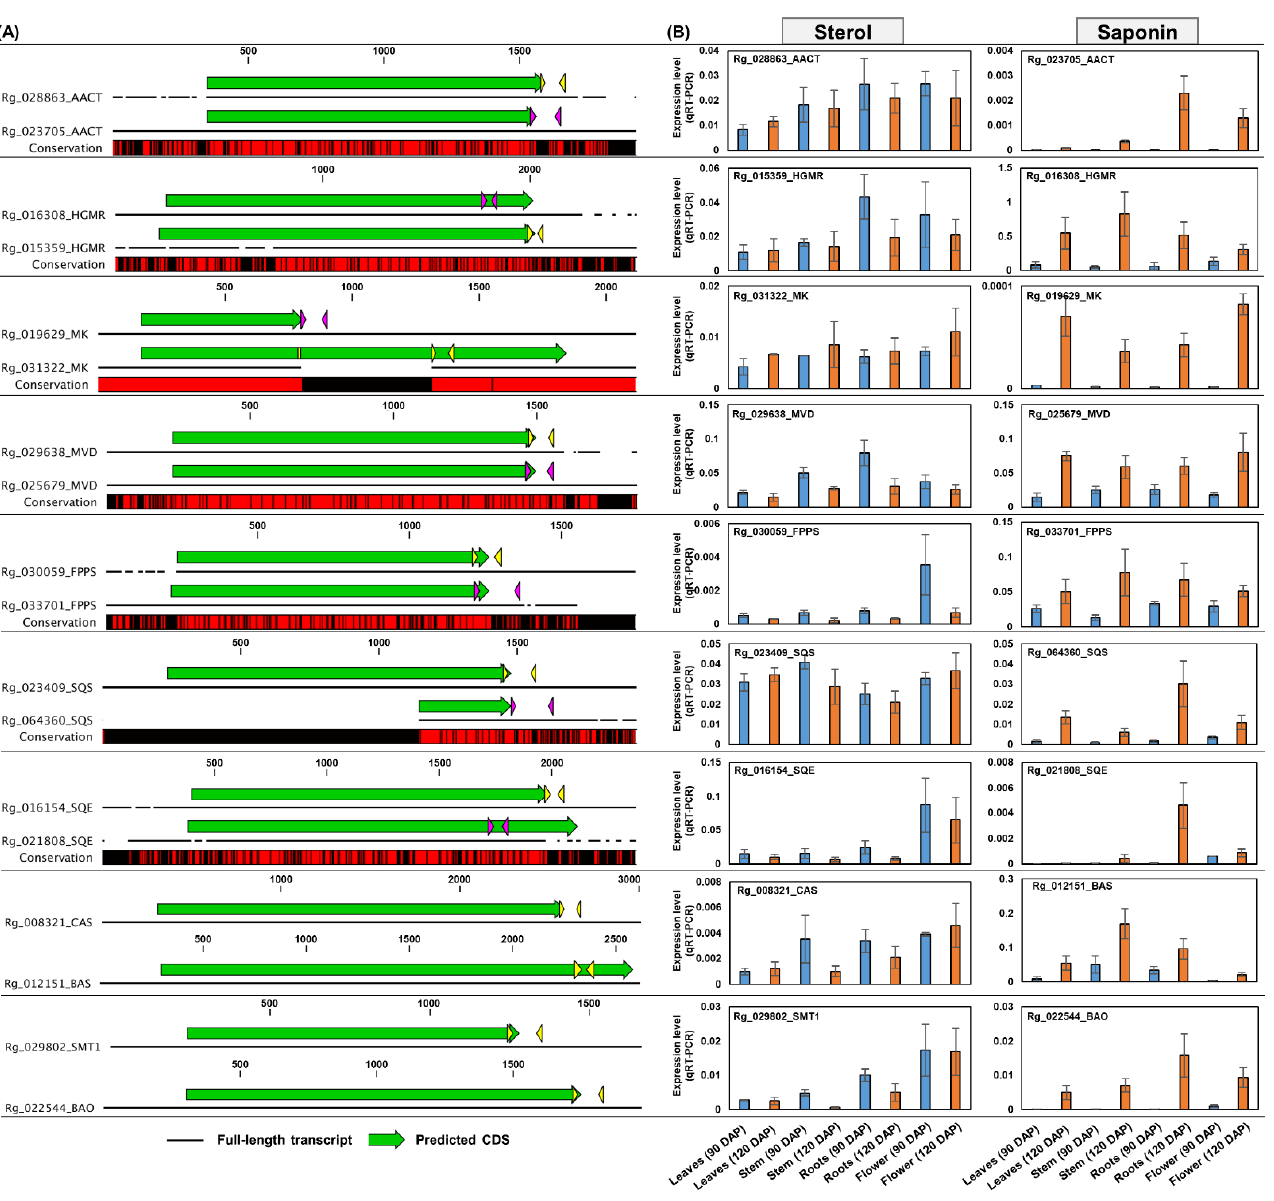
Figure 9. qRT ‐ PCR analysis of sterol and saponin biosynthesis genes via MVA pathway. ( A ) Schematic diagram of the nucleotide sequence structure of genes involved in sterol and saponin biosynthesis. Colored arrows indicate specific primer positions for the amplification of each gene. Red regions in conservation boxes indicate identical sequences between homologous genes. ( B ) qRT ‐ PCR analysis. The real ‐ time expression level of each gene was calculated using the delta ‐ CT method and visualized using a bar plot. Asterisks indicate significant differences between 90 DAP and 120 DAP samples (Student’s t -test, p < 0.05). Error bars represent standard deviations (SD) among three replicates. MVA , mevalonate